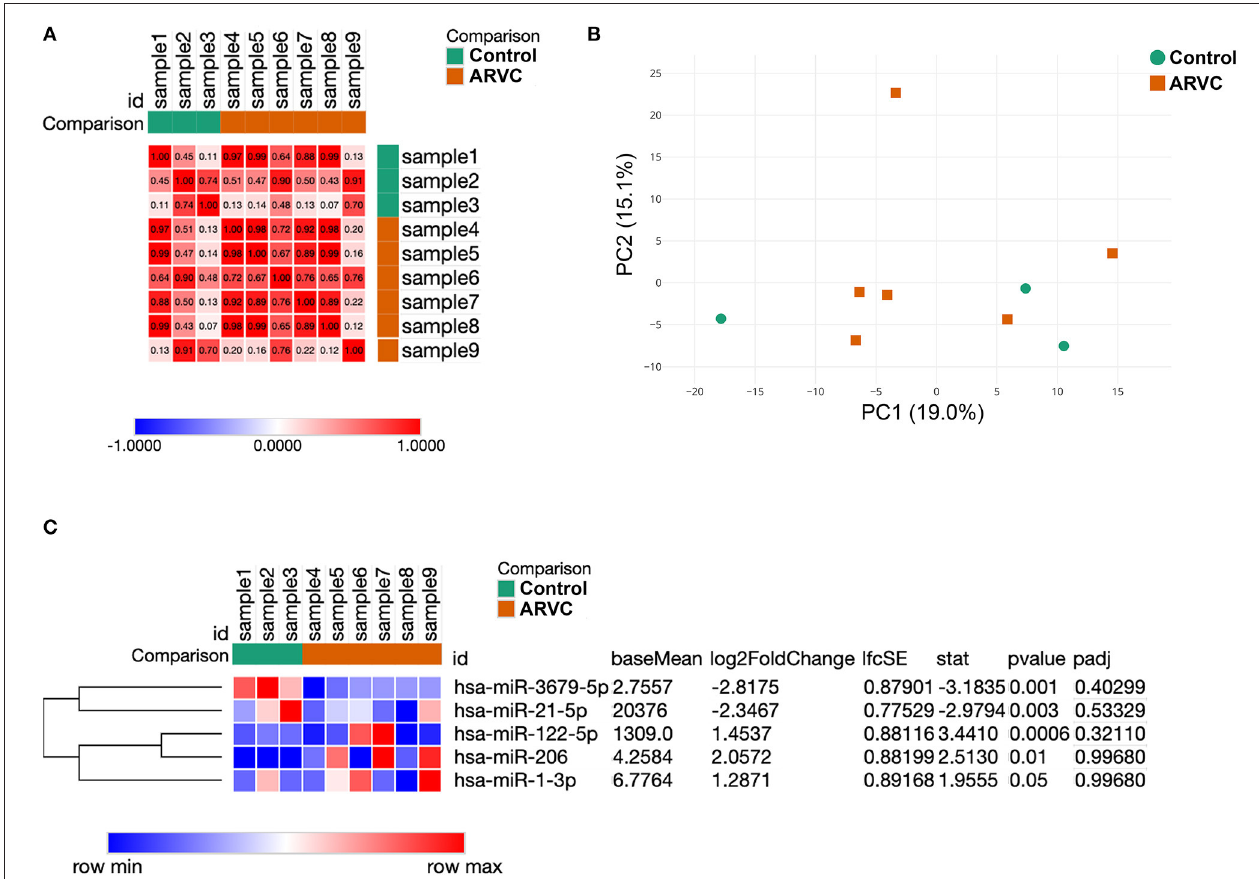
FIGURE 1 | Results of samples clustering and microRNA differential expression analysis. (A) Similarity matrix of pericardial fluid samples calculated based on their microRNA expression patterns. (B) Principal component analysis of pericardial fluid samples. (C) Expression heatmap and result of statistical analyses of five differentially expressed microRNAs between control and arrhythmogenic right ventricular cardiomyopathy (ARVC) pericardial fluid